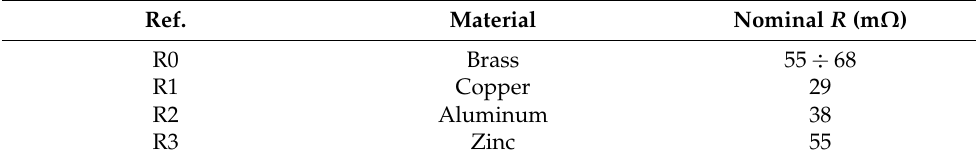
Table 1. List of the measured sample. The nominal R is evaluated at ∼ 12.9 GHz from the dc resistivity (cid:112) ρ of the material, assuming R s = µ 0 π f ρ . The samples are square in shape and of dimensions 15 × 15 × 3 mm 3 . Ref. Material Nominal R (m Ω ) R0 Brass 55 ÷ 68 R1 Copper 29 R2 Aluminum 38 R3 Zinc